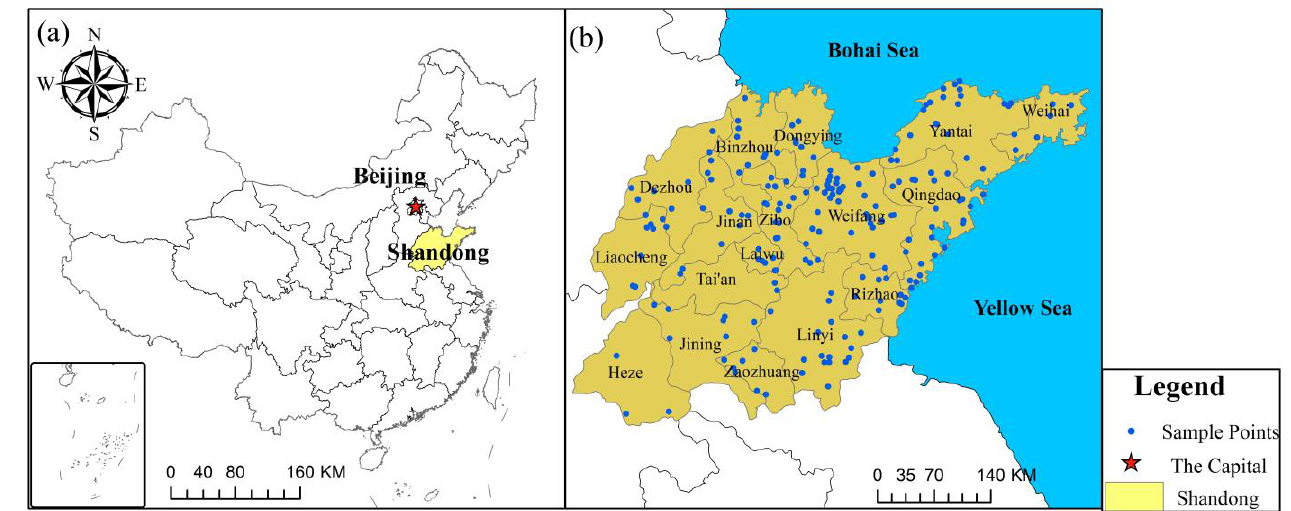
Figure 1. ( a ) Location of Shandong Province in China. ( b ) Distribution of survey sample sites in Shandong Province.